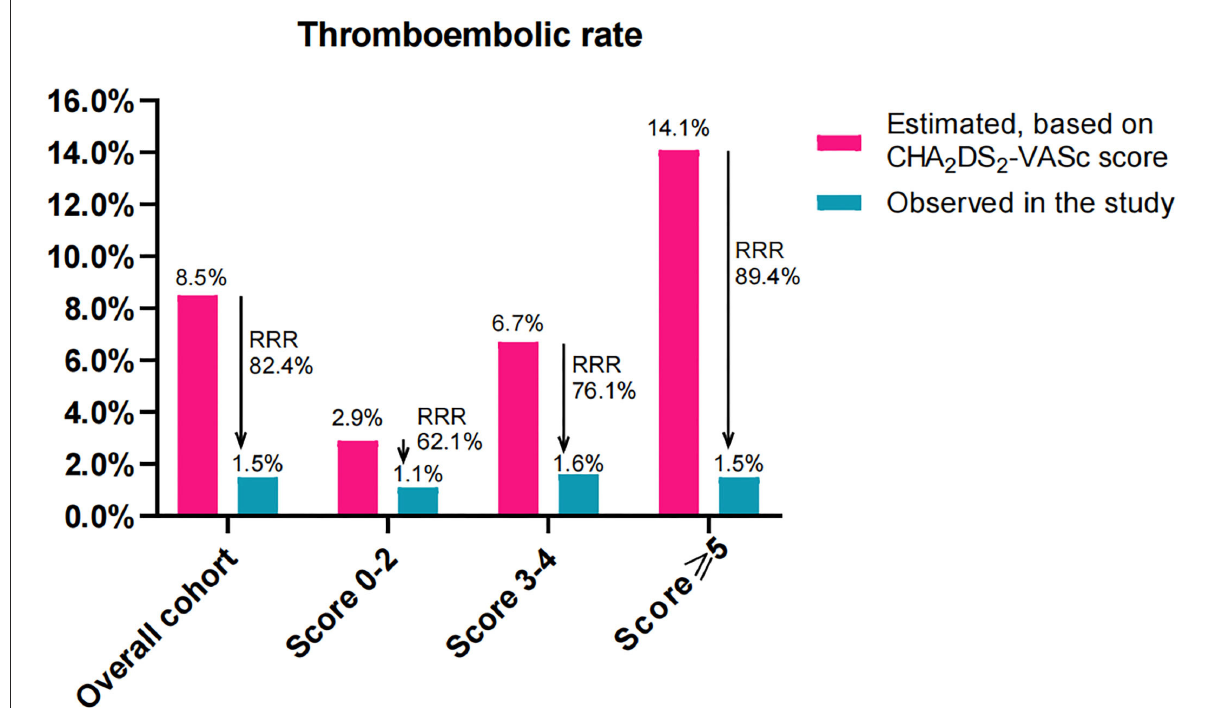
FIGURE4 Effectiveness of LAAC in risk reduction of thromboembolism (100 patient-years) during the follow-up in the study groups divided according to CHA 2 DS 2 -VASc score. RRR, relative risk